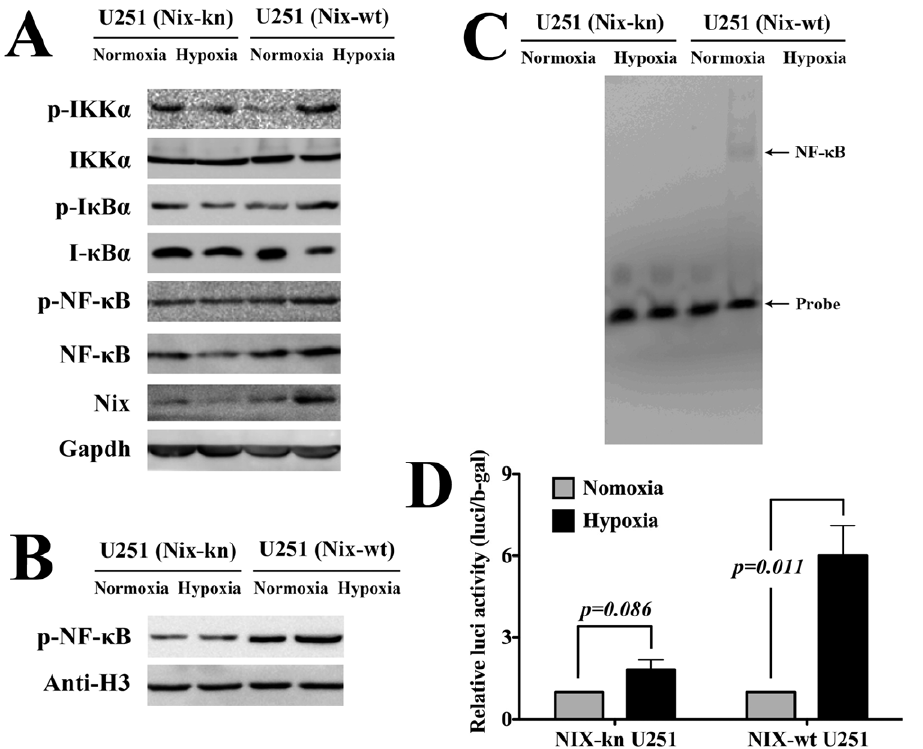
Figure 1. Nix protein positively regulates NF- k B activation in vitro. ( A ) When Nix-wt and Nix-kn U251 glioblastoma cell lines were incubated in DMEM medium under hypoxic conditions (5% CO 2 + 95% N 2 ), western blots revealed that the levels of Nix, p-NF- k B, p-IKK, and p-I- k B a were induced while I- k B a was degraded in Nix-wt U251 glioblastoma cells, but not in Nix-kn U251 glioblastoma cells. ( B ) Nuclear p-NF- k B was detected by western blot. The level of p-NF- k B in the nuclei of Nix-wt U251 cells was significantly higher than that of Nix-kn U251 cells. ( C ) The activation of NF- k B detected by EMSA. The activation of NF- k B was only detected in the Nix-wt U251 cells subjected to hypoxia. ( D ) The luciferase detection of NF- k B activation (repeated in triplicate). The activation of NF- k B was only detected in the Nix-wt U251 cells subjected to hypoxia (p ,